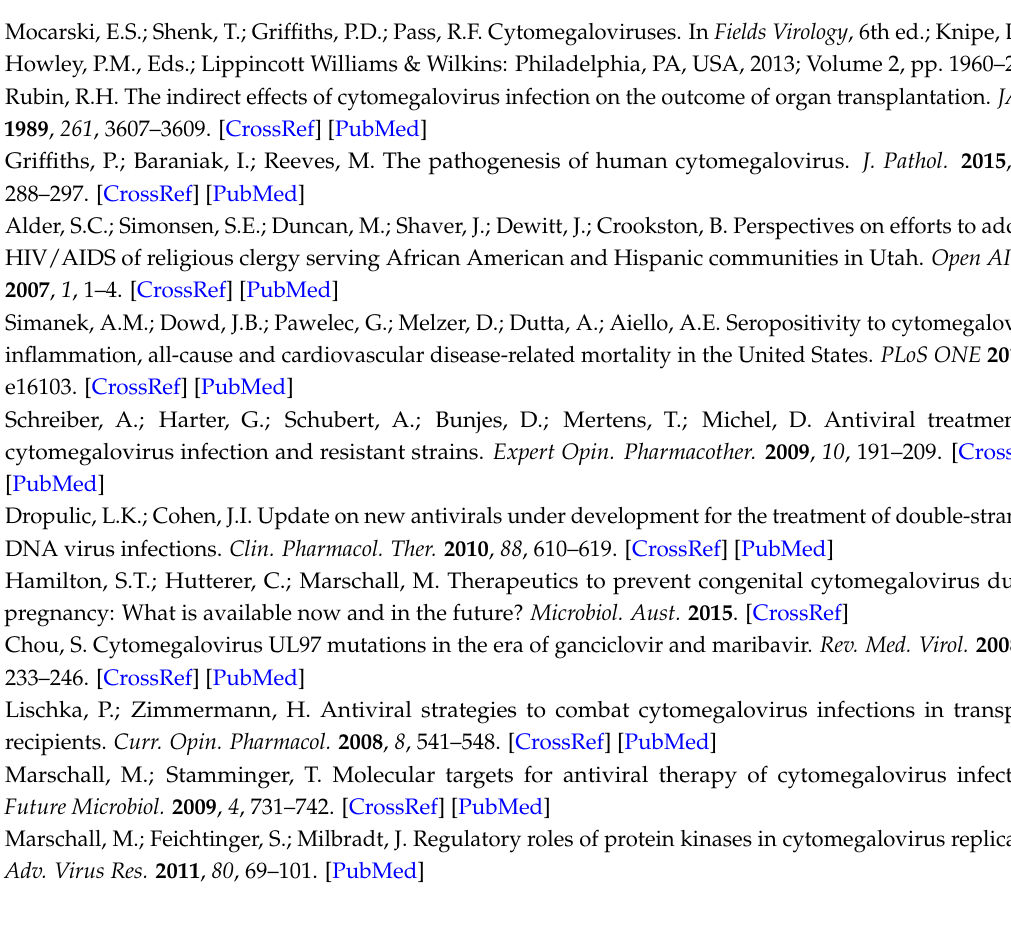
Table S1: Complete set of mass spectrometry data referring to Table 1, Table S2: Complete set of mass spectrometry data referring to Table 3, Table S3: Complete set of mass spectrometry data referring to Table